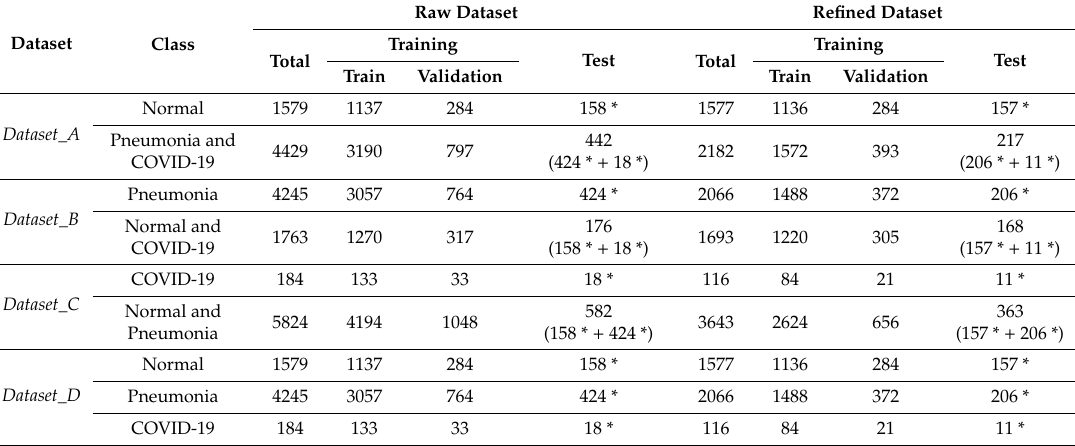
Table 1. Class distribution (train, validation, and test sets) of the raw and refined datasets. In the beginning, we have separated 158 normal, 424 pneumonia, and 18 COVID-19 images from the raw dataset and 157 normal, 206 pneumonia, and 11 COVID-19 images from the refined dataset. Here, * represents the same image in the test